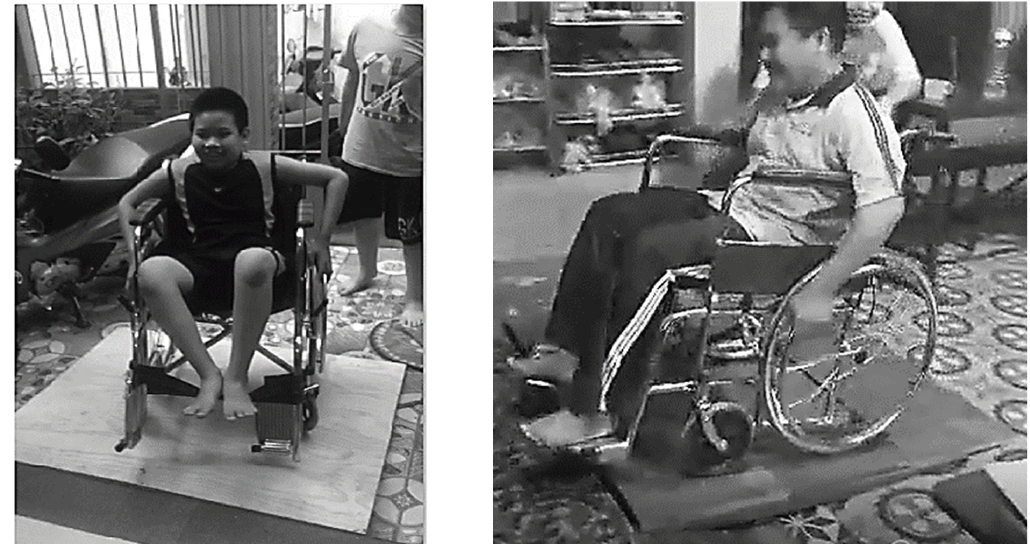
Figure 8. Groups 1 and 2 check the availability of